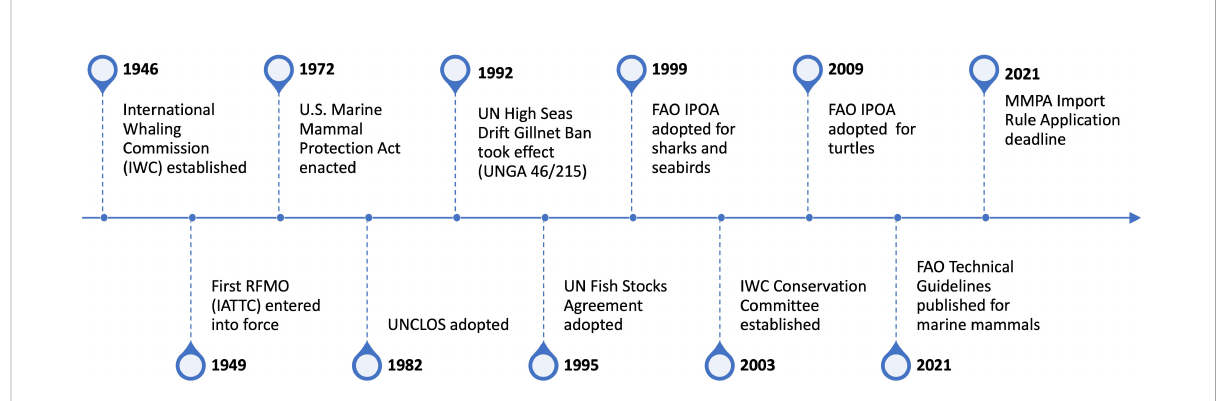
FIGURE 1 Timeline of major international fi sheries and marine mammal governance and agreement